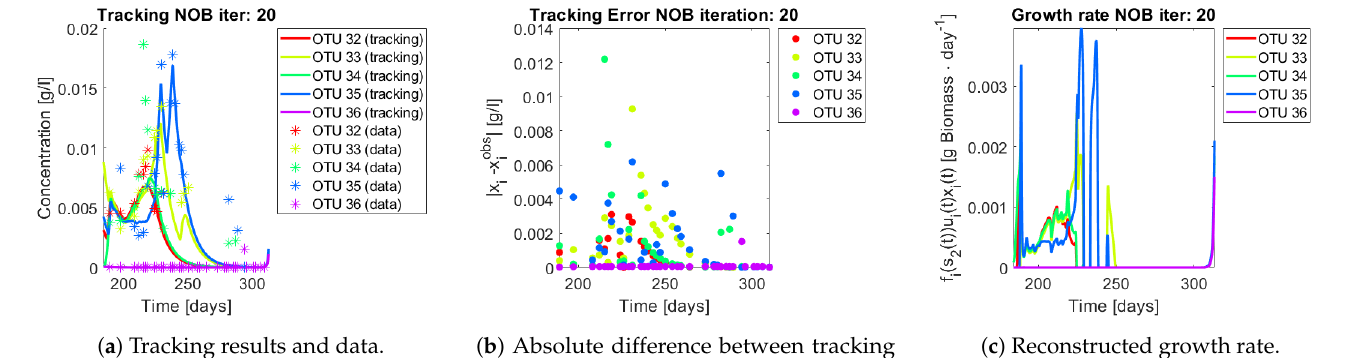
Figure 20. Results for OTU 32-36